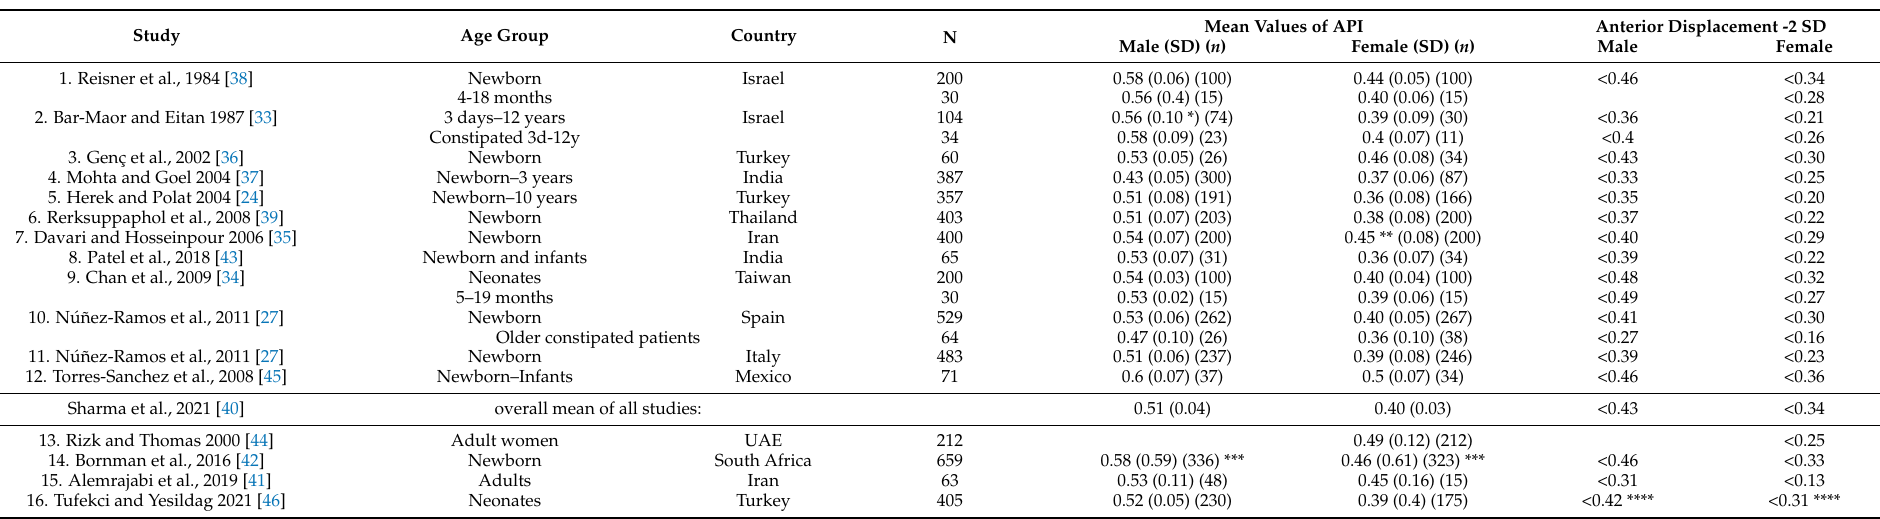
Table 1. Results of the API-values and the criteria for anterior displacement according to published studies (adapted from Sharma et al. [40]). Additional API values presented in the literature have been